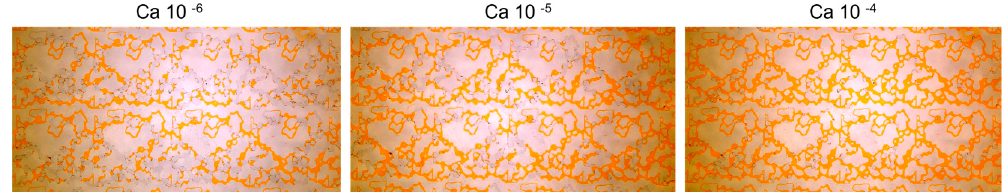
Figure 13. Images of the final saturation induced by imbibition processes at three different capillary numbers in HO49Y.